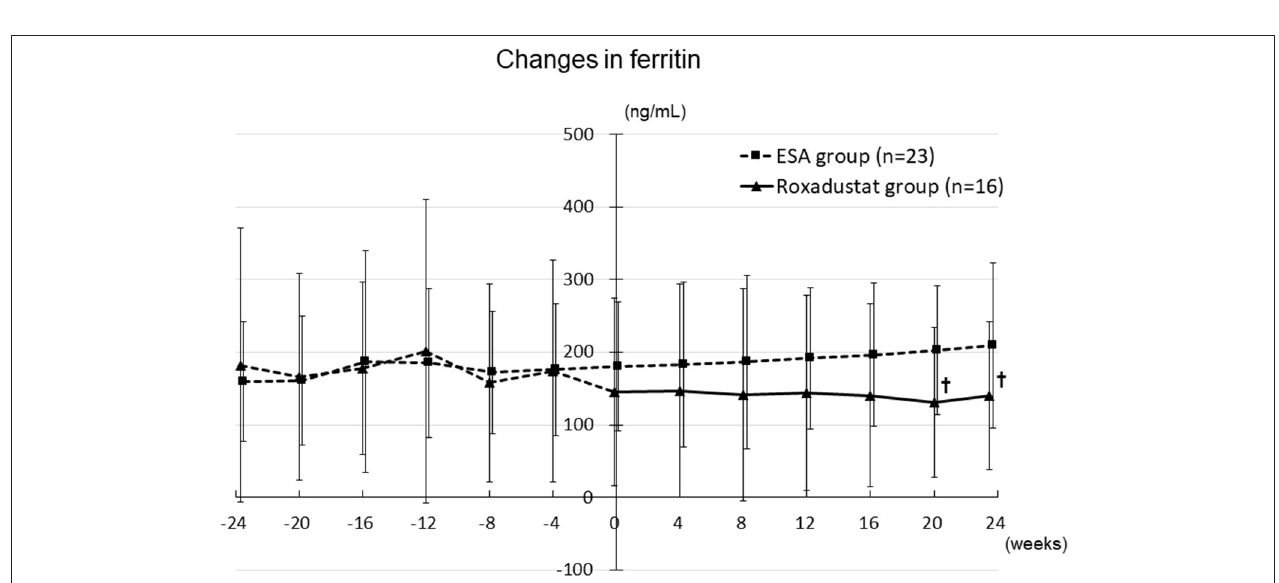
FIGURE 7 | Changes in the serum ferritin concentration in the Roxadustat and ESA groups. ESA, erythropoiesis-stimulating agent; † p < 0.05 vs. the ESA group.